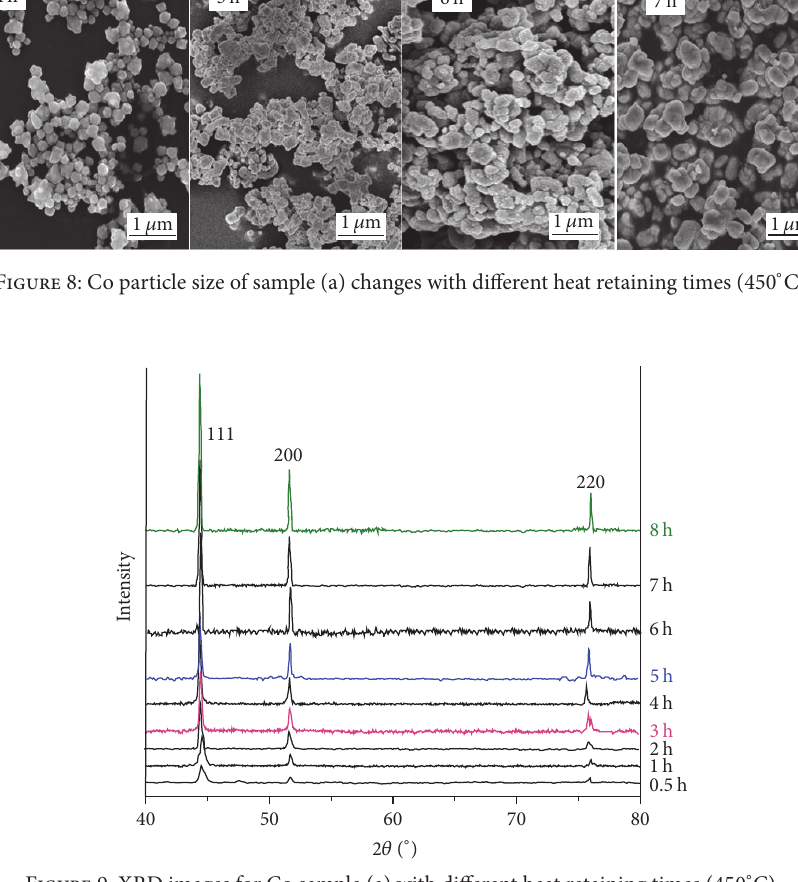
Figure 9: XRD images for Co sample (a) with different heat retaining times (450 ∘